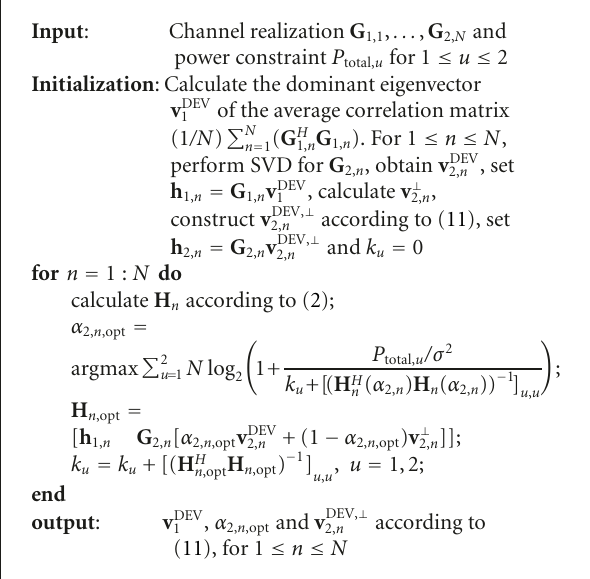
Algorithm 1: Spatial precoder optimization